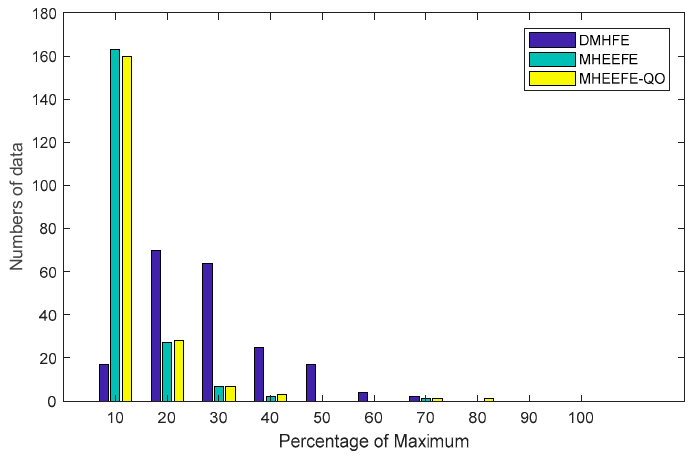
Figure 8. The distributions of MSEs with different models.